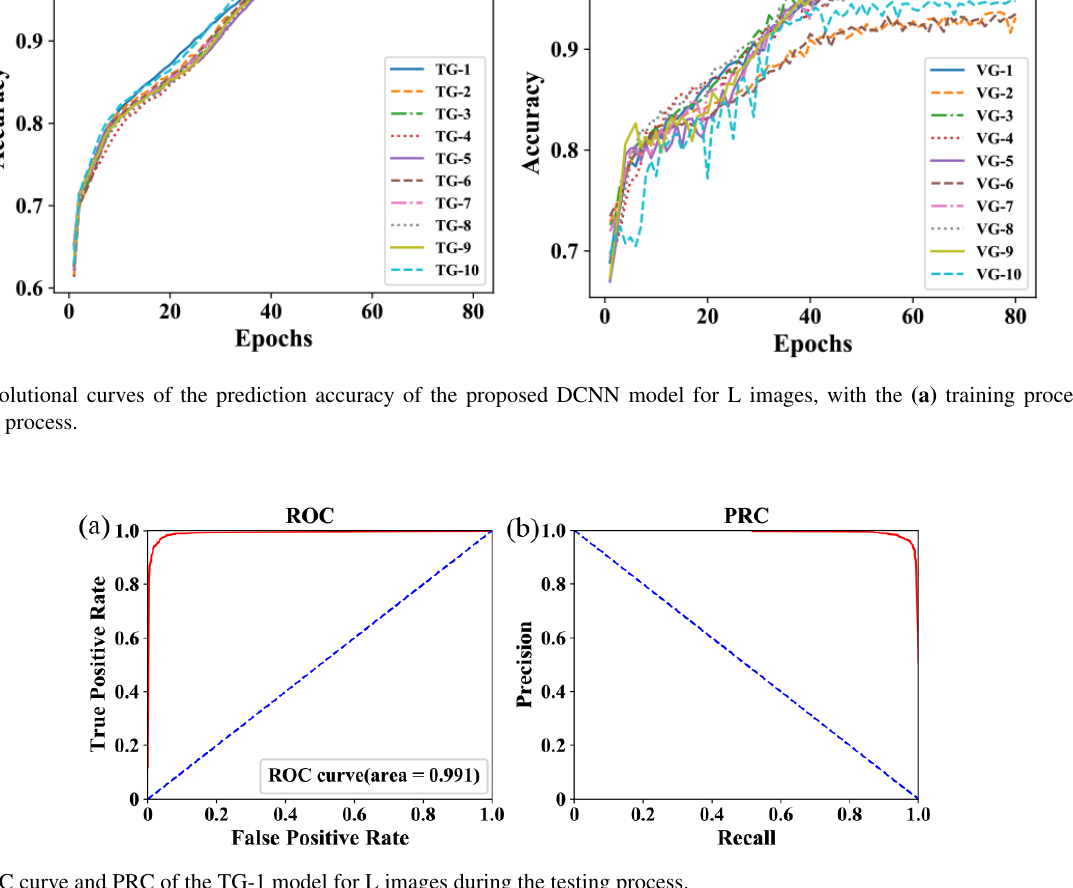
Figure 6. ROC curve and PRC of the TG-1 model for L images during the testing process.